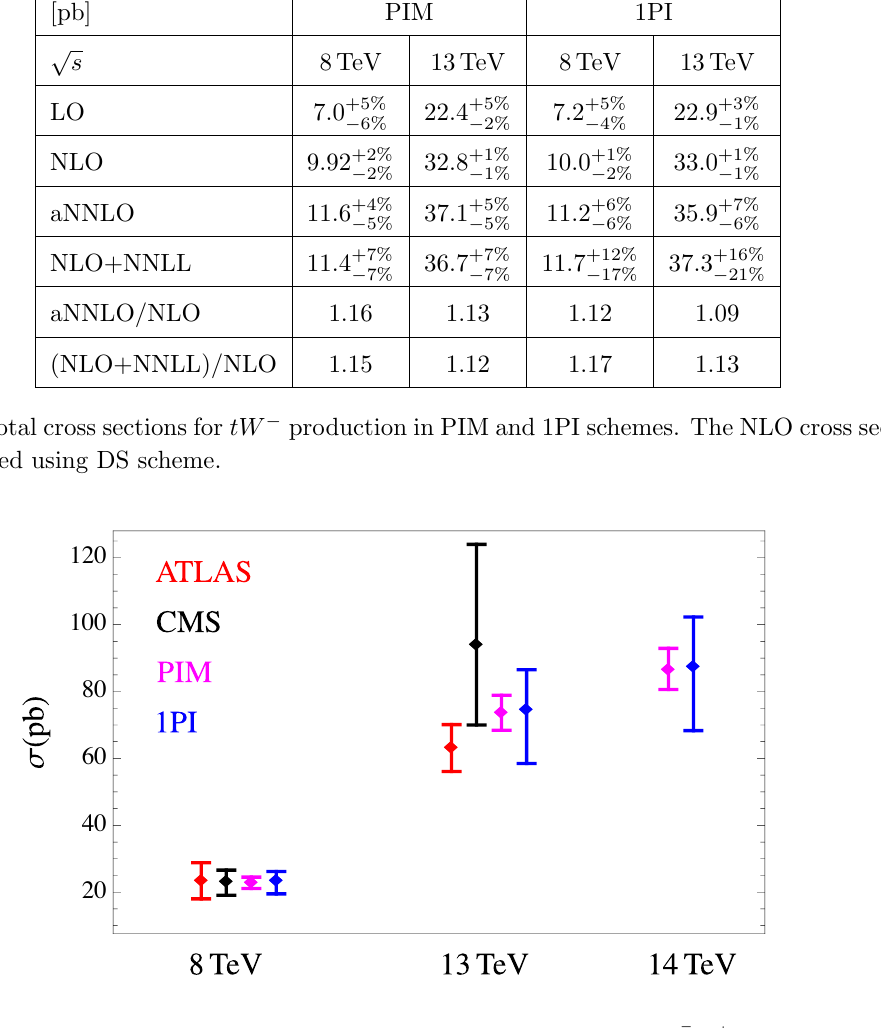
Figure 5 . Comparison between measured cross section for tW (cid:0) and (cid:22) tW + production at the LHC [2, 3, 6, 7] and RG-improved